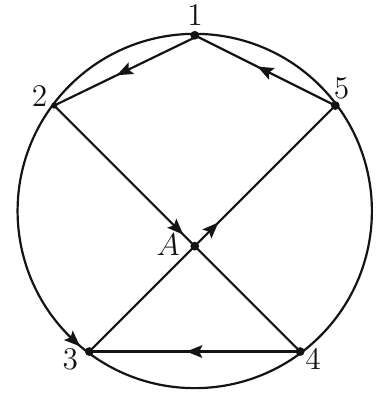
Fig. 5 Diagram for A BAS ( 1 , 2 , 3 , 4 , 5 | 1 , 2 , 4 , 3 , 5 )